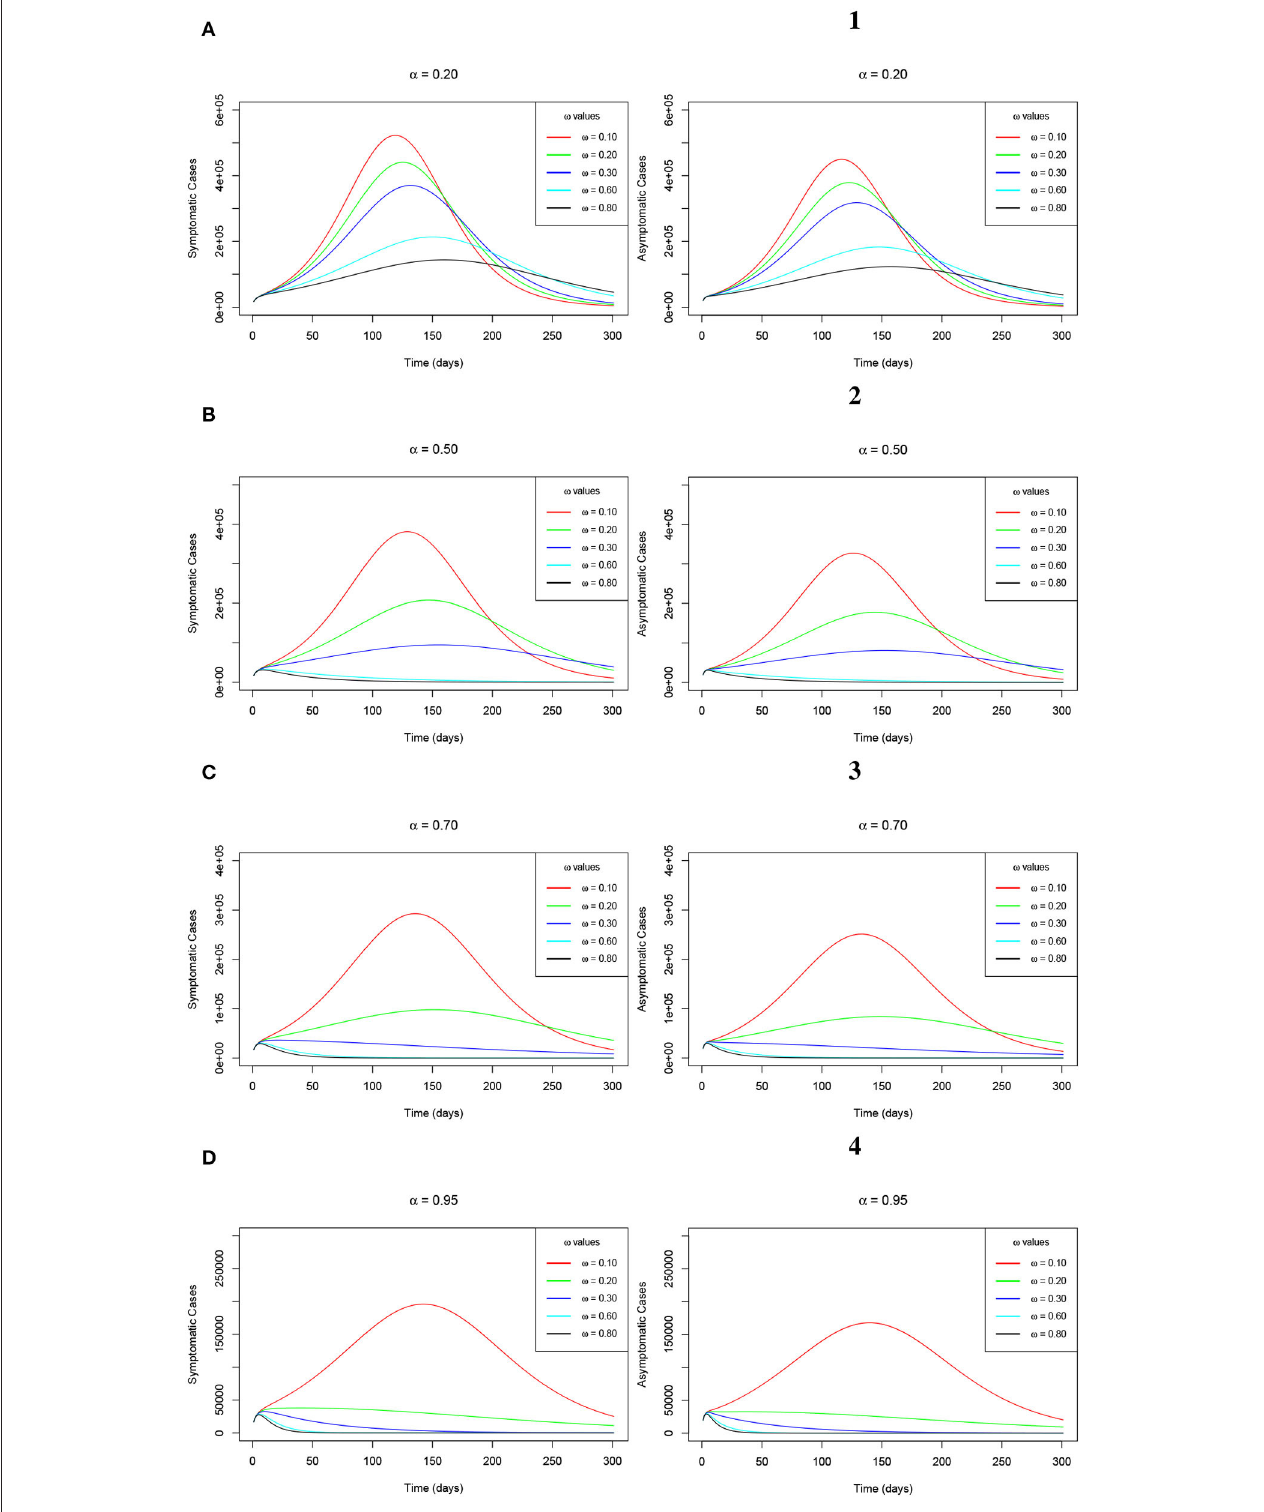
FIGURE 6 | (A–D) Simulations of the model (Equations 2–8) showing the trajectory of the number of symptomatic infections (left-hand-side sub-figures) and the number of asymptomatic infections (right-hand-side sub-figures) as ω varies at changing levels of α .